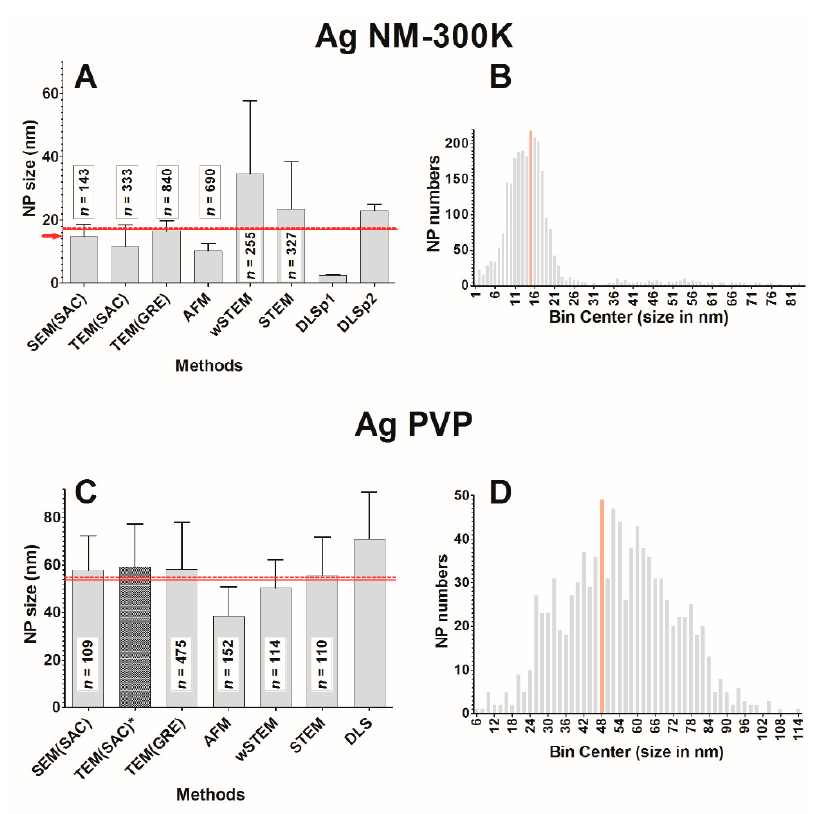
Figure 6. Average size measurements for Silver NPs: ( A ) Ag NM-300K; and ( C ) Ag PVP; and their respective frequency distance histogram distributions: ( B ) Ag NM-300K; and ( D ) Ag PVP. Methods are Dynamic Light Scattering (DLS), Scanning Electron Microscopy (SEM), Transmission Electron Microscopy (TEM), Atomic Force Microscopy (AFM), wet Scanning Transmission Electron Microscopy (wSTEM), and Scanning Transmission Electron Microscopy (STEM). The difference in the sample between wSTEM and STEM is the presence of liquid in the former, whereas it is dried in the latter. When two distinct populations of NPs are observed, they are reported with p1 and p2 keywords. The red lines in ( A , C ) indicate the global average NP size values determined by direct techniques only, 17.0 nm for NM-300K, and 53.9 nm for Ag PVP, whereas the dashed lines indicate the global NP size values determined by both direct and indirect techniques, 17.1 nm for NM-300K, and 55.8 nm for Ag PVP. The red arrow in ( A ) indicates the size of the NM-300K narrow population determined in the JRC report. The principal mode values are highlighted in pink on the frequency distance histograms: 15 nm for Ag NM-300K and 48 nm for Ag PVP. The * indicates that the value has been published earlier [47].